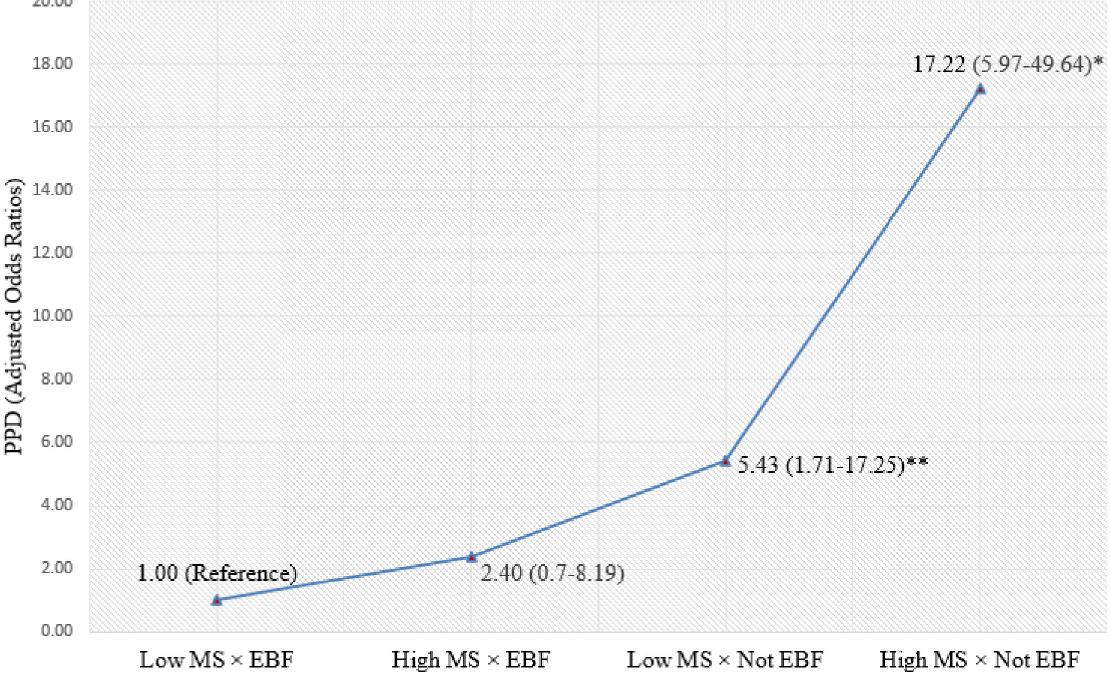
Fig 3. Combined effect of EBF and maternal perceived stress on postpartum depression. Controlling for maternal age, maternal education, place of residence, family monthly income, parity, pregnancy intention, obstetrical complications, mode of childbirth, social support, childhood sexual abuse, and previous depressive symptoms; Here � p < 0.001, �� p < 0.01; MS = Maternal stress; EBF = Exclusive breastfeeding.